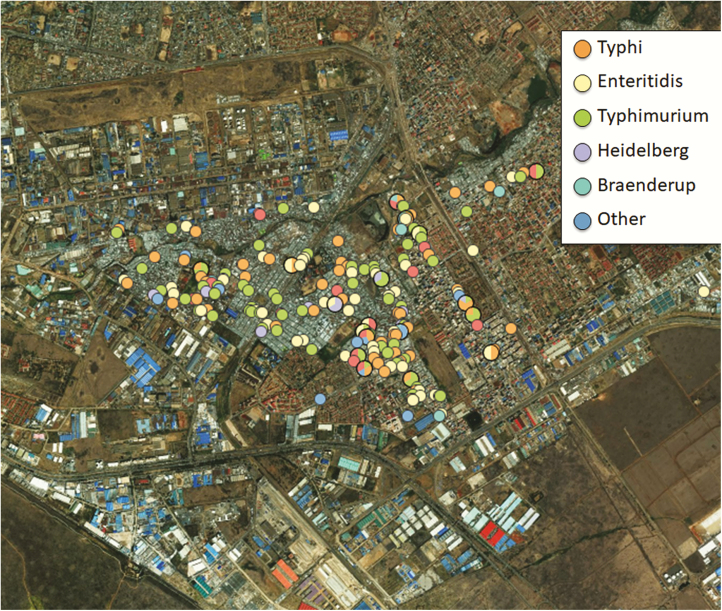
Hotspots of Salmonella serotypes in the 4 villages of Mukuru informal settlement. To the southeast of the map are godowns (warehouses) used by small-scale light industries.